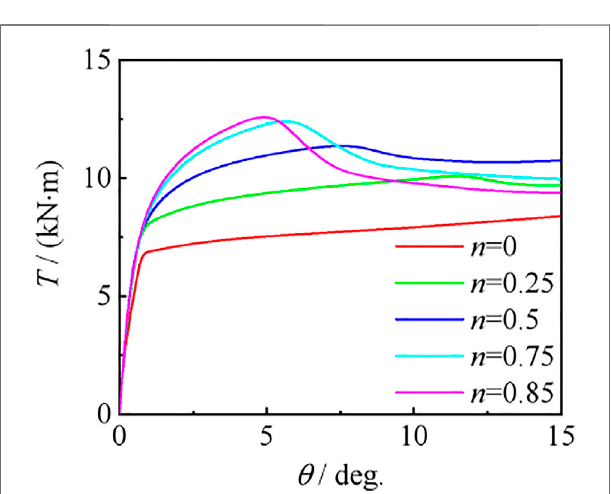
FIGURE 27 | n effectonthe T – θ curveofthecompressiontorsionmember.